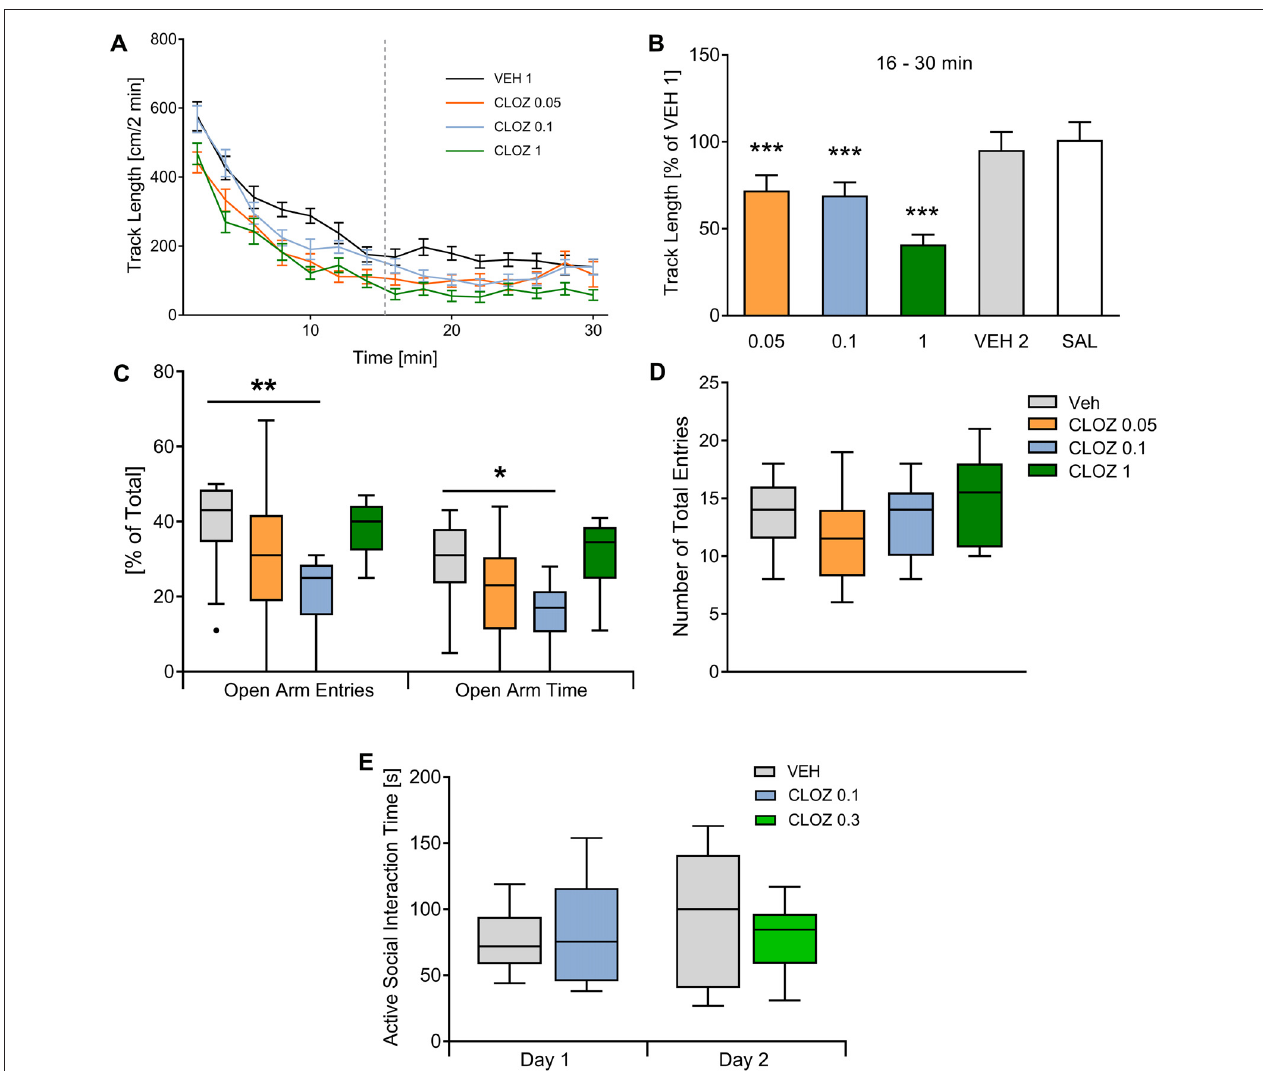
FIGURE 1 | Clozapine/CLOZ reduces locomotor activity and induces an anxious phenotype but does not affect social interaction. (A) Locomotor activity: directly after placing rats ( n = 19) in the open field, they showed high locomotor activity and reached a steady state after 15 min (data of the second vehicle injection/VEH 2 and saline/SAL were not different from VEH and are not shown to improve readability of the figure). (B) Track length in all conditions is expressed as percentage of the VEH 1 baseline value. For this steady-state activity, track length was affected by subject (repeated-measures one-way ANOVA followed by Dunnett’s test; F ( 18,90 ) = 8.85; p = 3 × 10 − 13 ) and treatment ( F ( 5,90 ) = 16.34; p = 2 × 10 − 11 ). We observed a dose-dependent decrease after low-dose CLOZ administration (all compared against VEH injection). The lowest doses used caused similar decreases in track length (0.1 mg/kg CLOZ: p = 2 × 10 − 4 , this corresponds to 69.2 ± 7.5% of the track length after VEH injection; 0.05 mg/kg CLOZ: p = 10 − 4 ; 72.1 ± 8.73%). There was an even stronger reduction with 1 mg/kg CLOZ ( p < 10 − 4 ; 40.9 ± 5.7%). The second vehicle (VEH 2) injection was performed to test if repetition influences steady-state activity, but no difference was observed ( p = 0.27; 95.4 ± 10.2%). Also, SAL treatment didn’t change the track length ( p = 0.56; 101.1 ± 10.2%). Data are represented as mean ± standard error of the mean (SEM). (C,D) Elevated plus-maze: the percentage of open arm entries/%OAE ( H = 13.0, p = 0.0046, Kruskal-Wallis test) and the percentage of open arm time/%OAT ( H = 11.3, p = 0.010, Kruskal-Wallis test) was different between groups. Post hoc tests showed that the dose of 0.1 mg/kg induced an anxious phenotype. Both the %OAE ( p = 0.023, Dunn’s multiple comparisons test) and %OAT ( p = 0.023) were decreased with this dose ( n = 9). 0.05 mg/kg and 1 mg/kg CLOZ did not affect the %OAE or the %OAT significantly. The total number of entries (controlling for locomotor activity effects) were not different between groups ( p = 0.24, Kruskal-Wallis test). (E) Social interaction: no significant differences concerning cumulative active social interaction time were observed with both doses tested (0.1 mg/kg and 0.3 mg/kg CLOZ, p = 0.99 and p = 0.57, n = 10 per group). Data displayed as median and the first and third quartile (P 25 , P 75 ; Tukey-style whiskers) ∗ p < 0.05, ∗∗ p < 0.01, ∗∗∗ p <